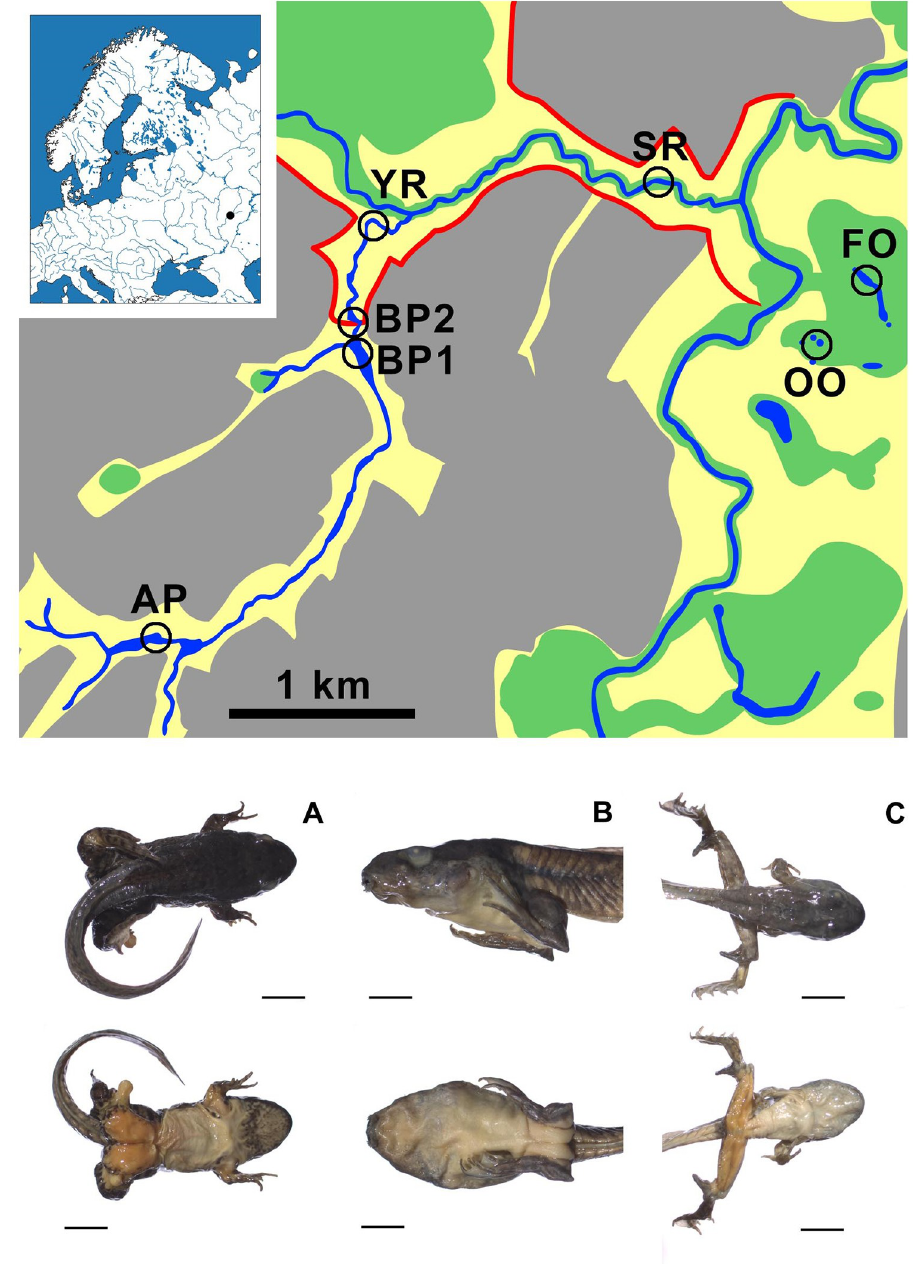
Fig 1. Sampling locations in Ostrovtsovskaya Lesostep’. Small rivers Yuzhnaya (YR) and Selimutka (SR), the floodplain oxbows located in open landscapes (OO) and in the forest (FO), the active beaver pond (BP1) and the drained beaver pond (BP2), and the anthropogenic pond (AP). A, B, C–severe forms of the anomaly P syndrome in Pelophylax ridibundus inhabited Ostrovtsovskaya Lesostep’. Scale bar (A–C) is mm. (abundance of mollusks and screening for cercariae emergence) we investigated seven water objects to reflect all typical aquatic habitats in the forest-steppe landscapes of this part of the nature reserve: small rivers Yuzhnaya (YR) and Selimutka (SR); the floodplain oxbows located in open landscapes (OO) and in forest (FO); the active beaver pond (BP1) and the drained